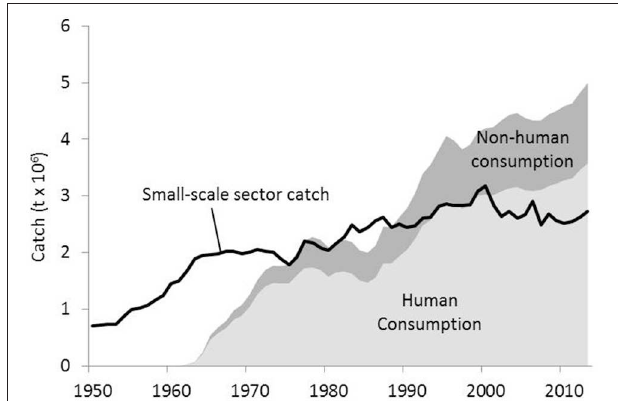
FIGURE 6 | The proportion of industrial sector catch (aggregated across all four countries) that is used for human and non-human consumption (fishmeal). The solid line shows small-scale sector